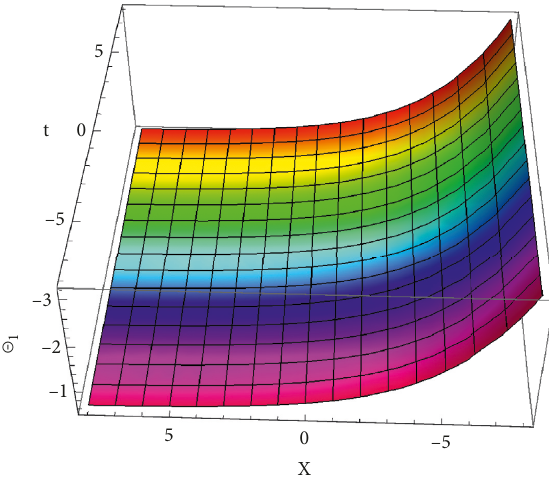
Figure 7: Plots of equations (73), for m � 0, ξ � 0 . 2, λ